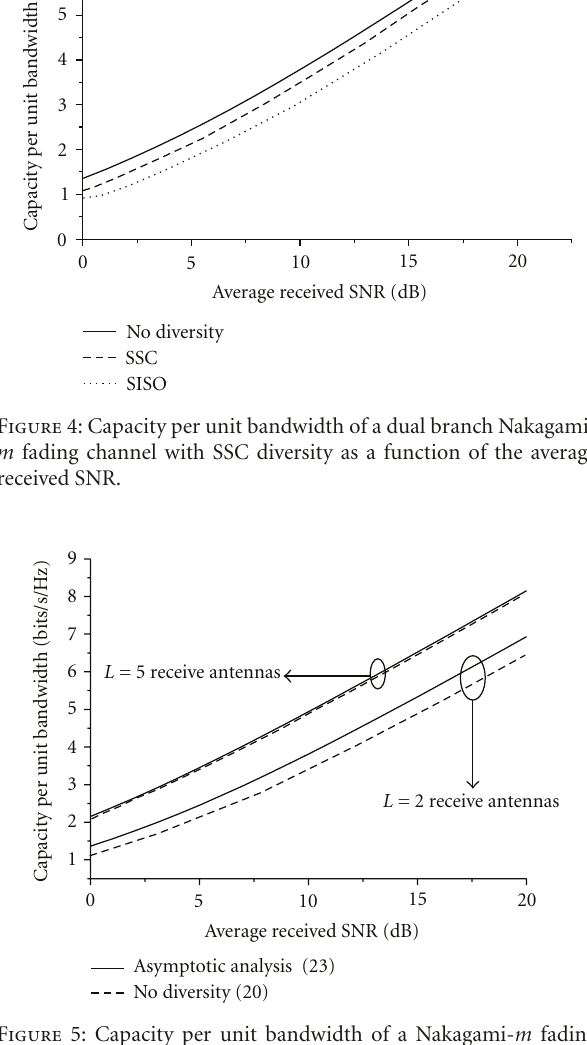
Figure 5: Capacity per unit bandwidth of a Nakagami- m fading channel with L = 5 and L = 2 receive antennas without any diversity technique as a function of the average received